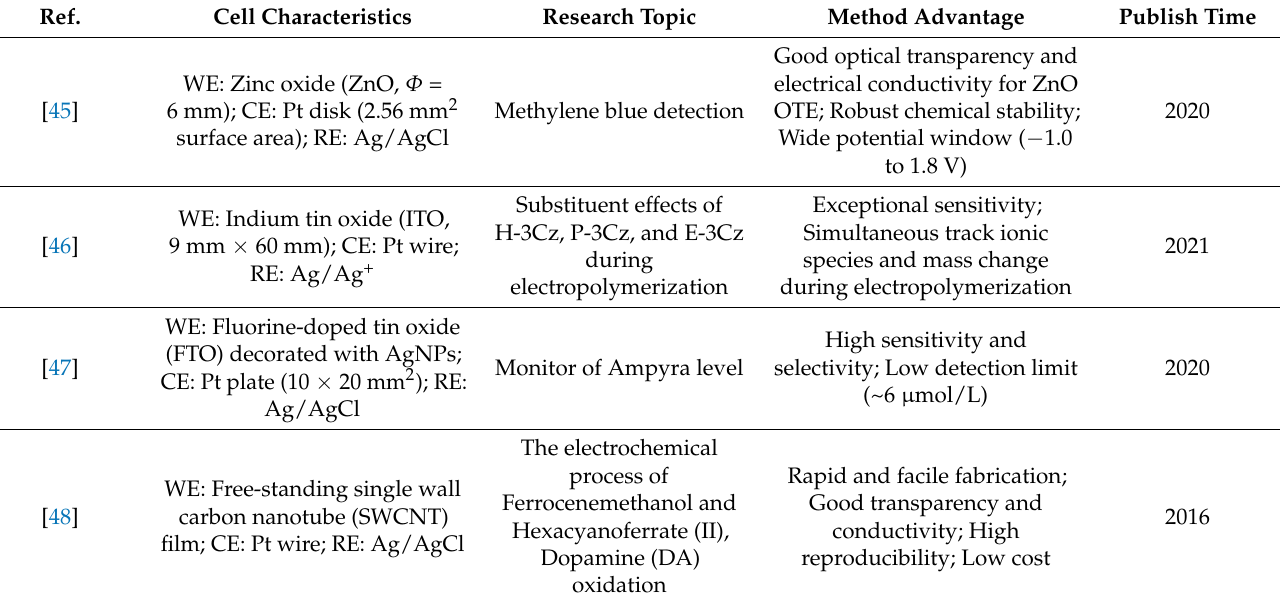
Table 1. A brief comparison of different